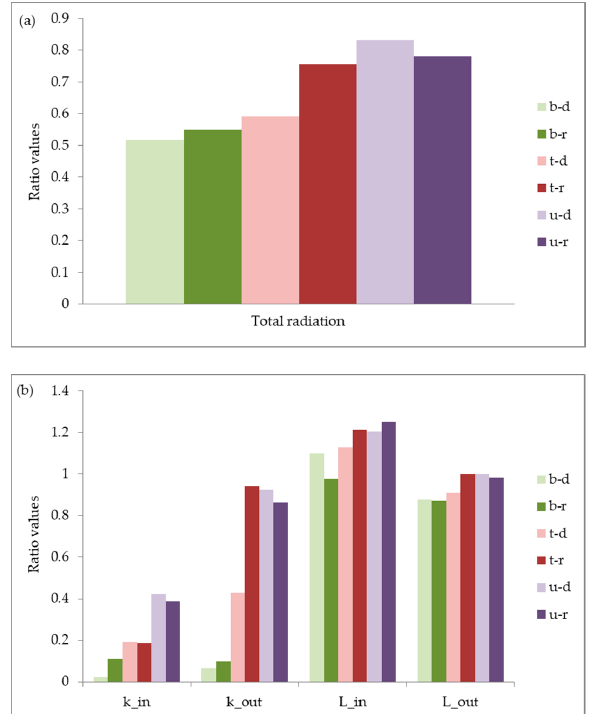
Figure 9. ( a ) Median ratio values of the total incoming radiation measured by the net radiometer for each strategy. For the identification of the columns, “d” is the downtown setting, “r” is the residential setting, “b” is the building shade strategy, “t” is the tree shade strategy, and “u” is the umbrella shade strategy; ( b ) Median ratio values in the various components measured by a net radiometer for each strategy. For the x -axis, “k” refers to incoming shortwave radiation, “L” refers to incoming longwave radiation, “in” refers to measurements made from the upward-facing sensor, “out” refers to measurements made from the downward-facing